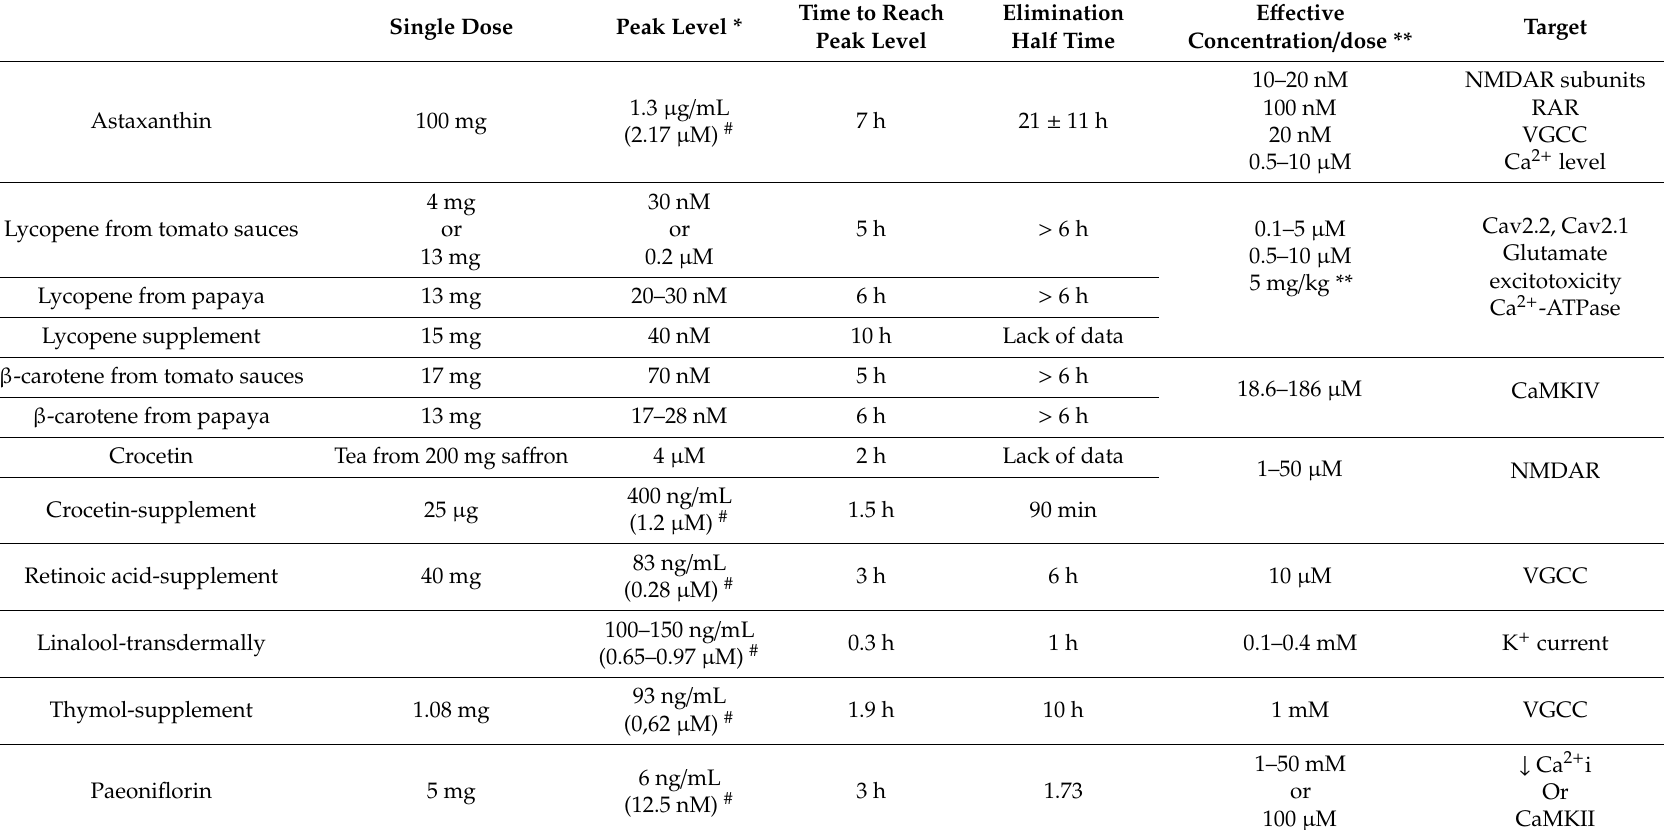
Table 2. Comparison of serum concentrations after administration of a single dose of selected terpenes and e ff ective concentrations which exert biological e ff ects for some exemplary